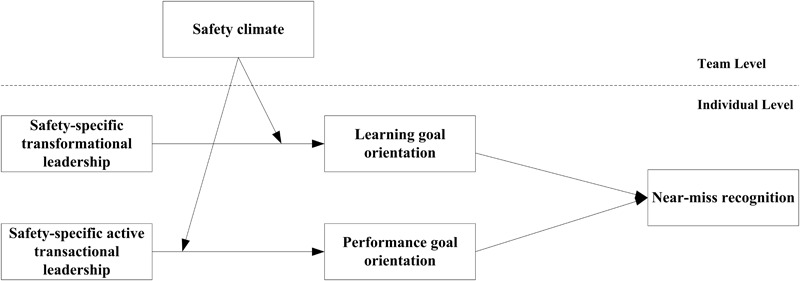
The research model.